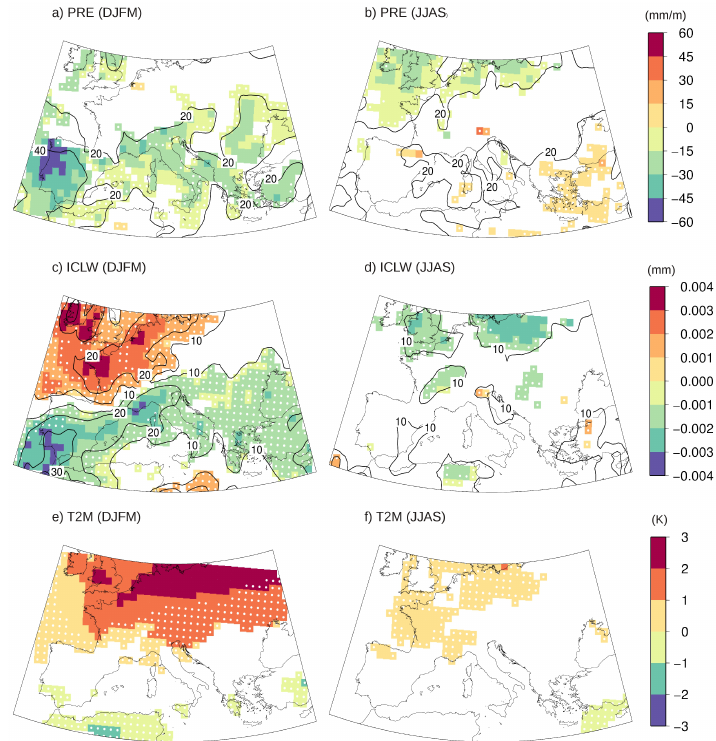
Fig. 4. As in Fig. 3c and d, here for (a, b) precipitation (in mmmonth − 1 ), (c, d) column integrated cloud water (in mm) and (e, f) 2m temperature (in